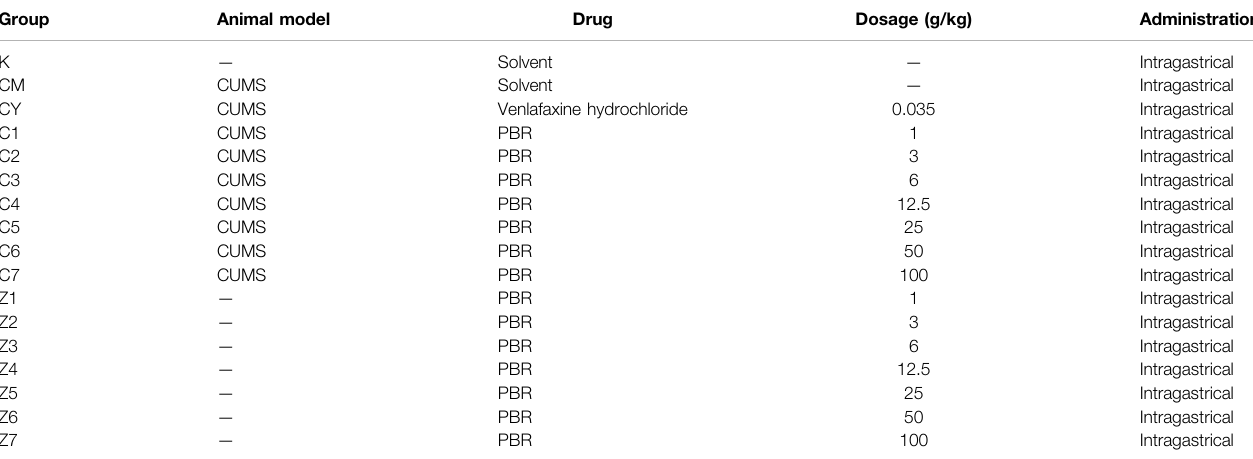
TABLE 1 | Animal grouping and processing.